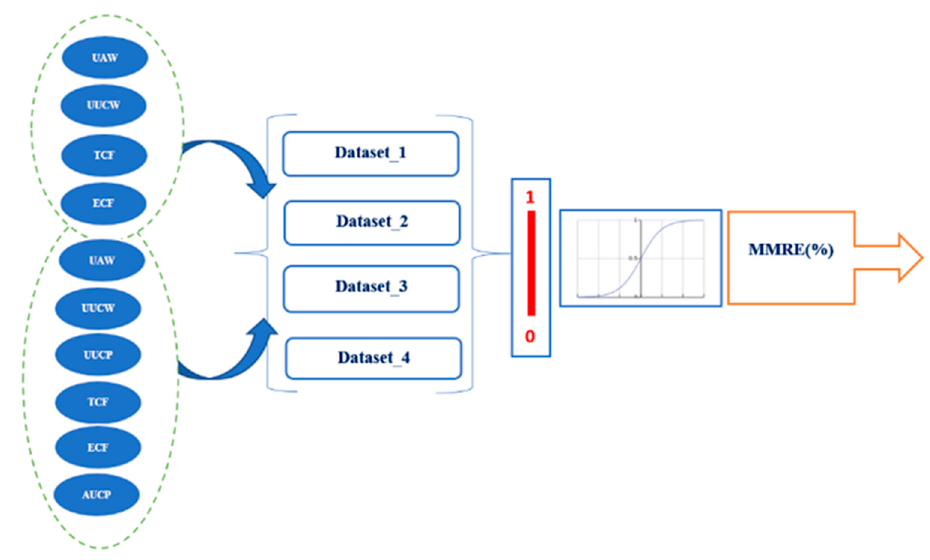
Figure 3. Robust design algorithm for performing the experiment (UCP).